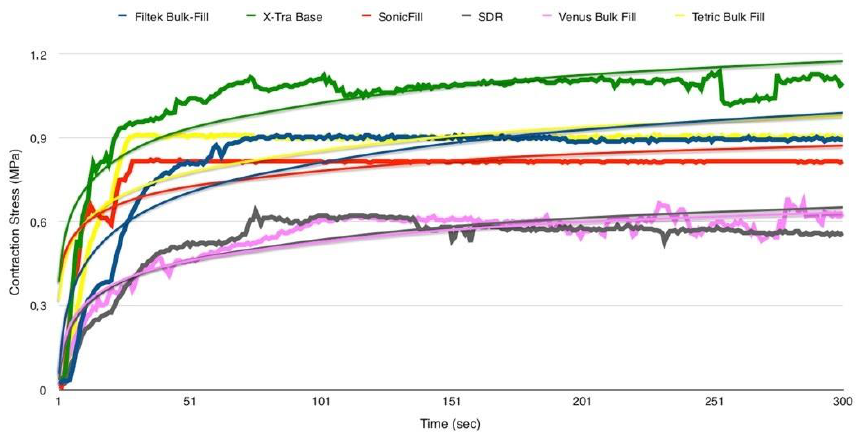
Table 4. Mean values and standard deviation (SD) for shrinkage stress (SS) and time to achieve maximum stress rate (t-Max) of the tested materials. Different superscript letters indicate significant difference within column (p < 0.05).